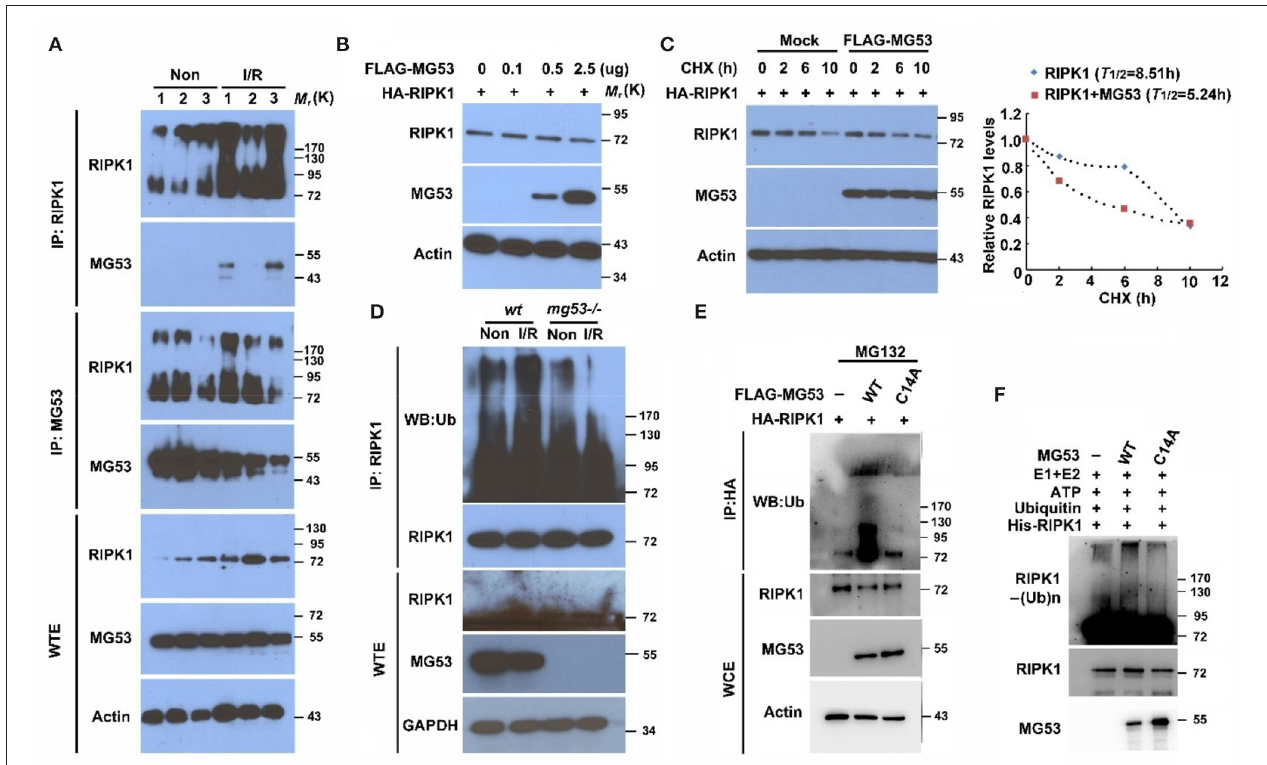
FIGURE 3 | MG53 induces RIPK1 protein degradation through the ubiquitin pathway. (A) Co-immunoprecipitation of RIPK1 and MG53 was performed with infarct (I/R) and non-infarct (Non) areas of wt heart lysates. n = 3 per group. WTE: whole tissue extraction. (B) HEK293 cells were transfected with HA-RIPK1 and different doses of Flag-MG53 plasmid (0–2.5 µ g). Western blot analysis showed dose-dependent regulation of RIPK1 by MG53. (C) HEK293 cells were transfected by either HA-RIPK1 or a combination of HA-RIPK1 and FLAG-MG53. Cycloheximide (CHX) was added to the culture media, and the expression of RIPK1 was measured at indicated time points. The half-life of RIPK1 was calculated by ImageJ analysis ( right panel ). (D) Poly-ubiquitination of RIPK1 was detected in wt and mg53-/- hearts with (I/R) or without (Non) I/R injury. (E) HA-RIPK1 was co-expressed either with wt FLAG-MG53 or C14A-MG53 mutant in HEK293 cells. MG132 (10 µ M) was used to block protein degradation. (F) In vitro ubiquitination of RIPK1 was performed with either wt recombinant or mutant (C14A) recombinant MG53 protein. Poly-ubiquitination of RIPK1 was determined by western blot